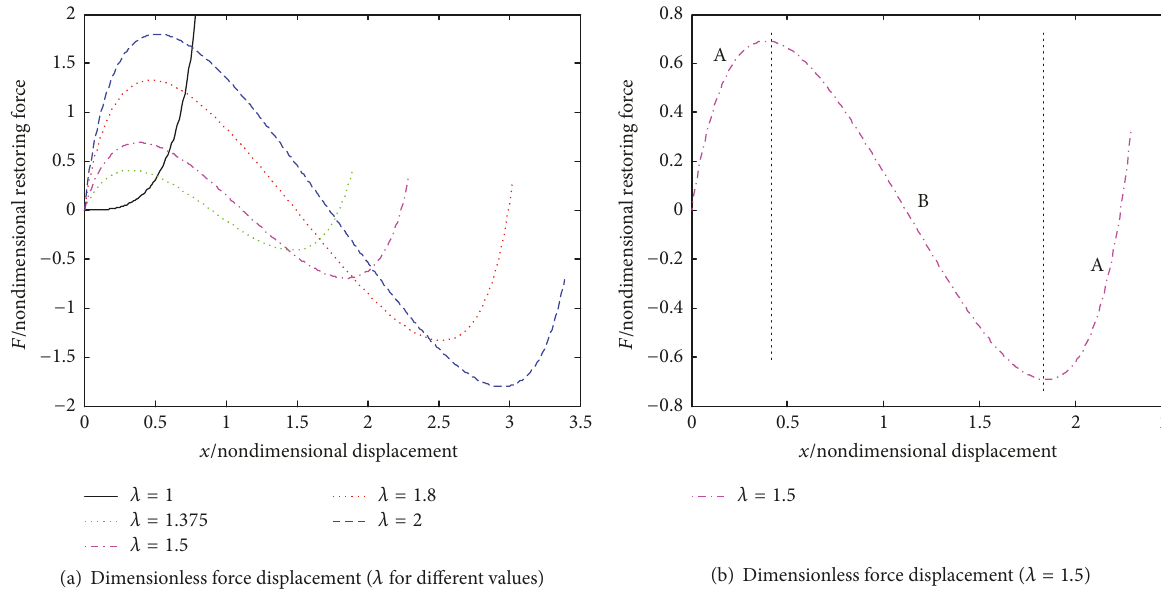
Figure 3: Dimensionless force